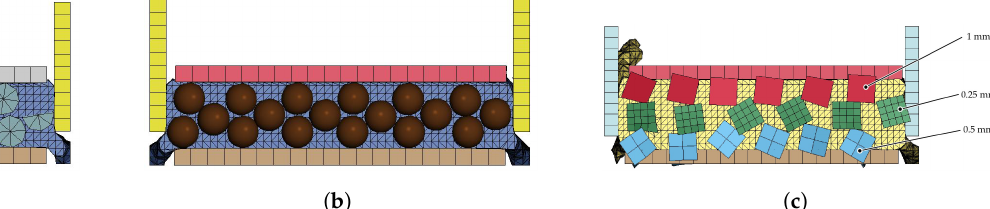
Figure 11. Contact behaviour of fibres with different elements types after compression with the ALE approach: ( a ) Beam elements; ( b ) discrete element chain; ( c ) 3D solid elements with varying element length. ( a ) Fibre arrangement after compression, beam element. ( b ) Fibre arrangement after compression, discrete element. ( c ) Fibre arrangement after compression, 3D solid